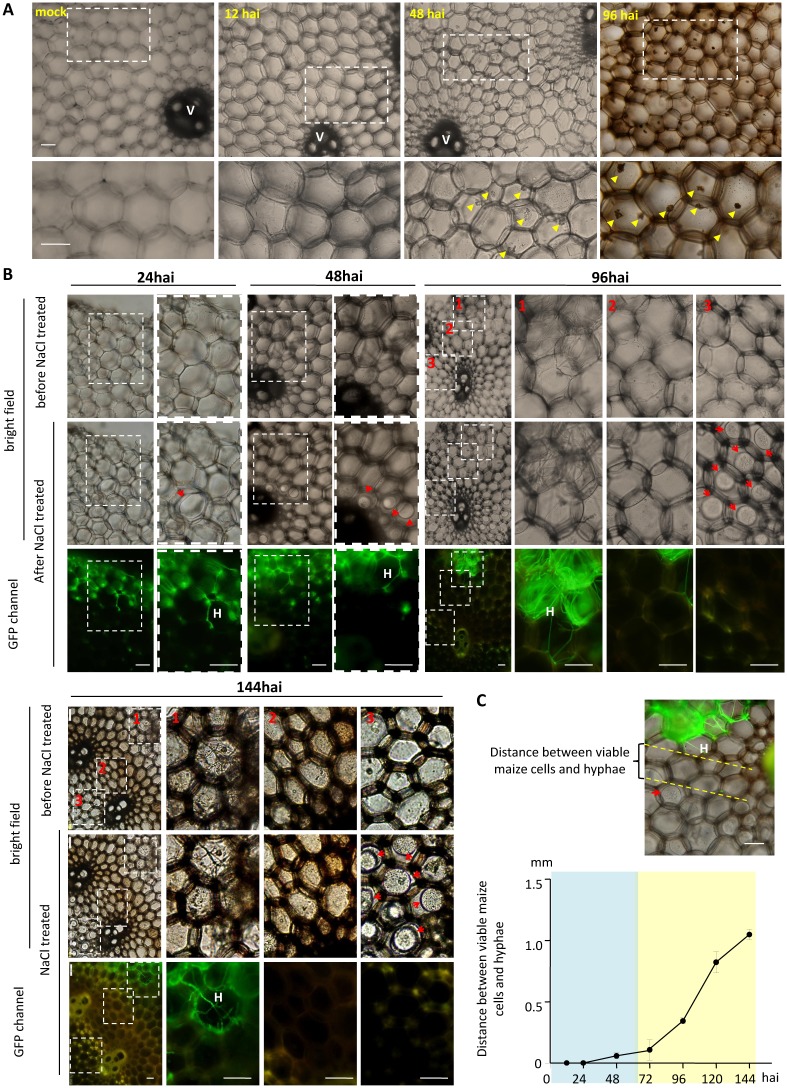

graminearum caused nuclear abnormalities and cell death in nearby maize cells from 48 hai.
F. (A) Representative bright field images of maize stalk pith tissues. Images 12, 48 and 96 hai were taken of the cross sections preceding the hyphal front (as indicated by the red broken line in Fig 2A). Yellow arrowheads point to nucleus-like structures. V: vascular bundle. (B) Representative images showing infected maize pith tissues before and after 1 M NaCl treatment for 10 min. F. graminearum AmCyanPH-1 hyphae are visible as green lines under a GFP channel. Red arrows point to maize cell membranes away from cell walls. H: hyphae. White scale bar = 100 μm. (C) The shortest distances between fungal hyphae and maize cells undergoing plasmolysis were measured. Error bars indicate SD. Sample size n ≥4. Images in this figure were all taken from cross sections. hai: hours after inoculation.